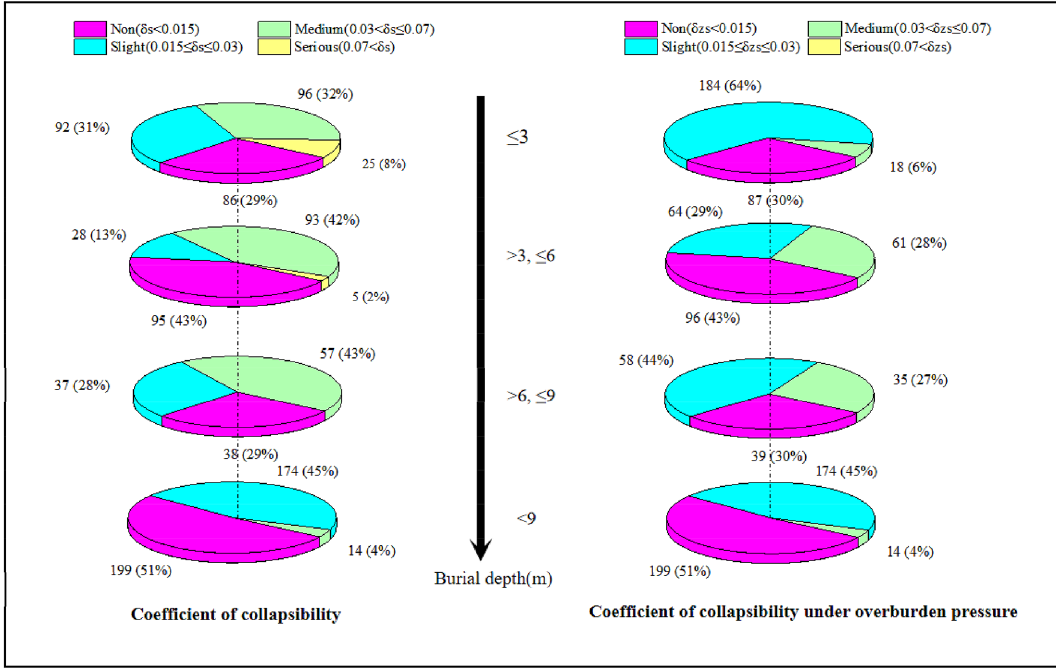
Figure 3. Collapsibility level (δs and δzs) distribution under different burial